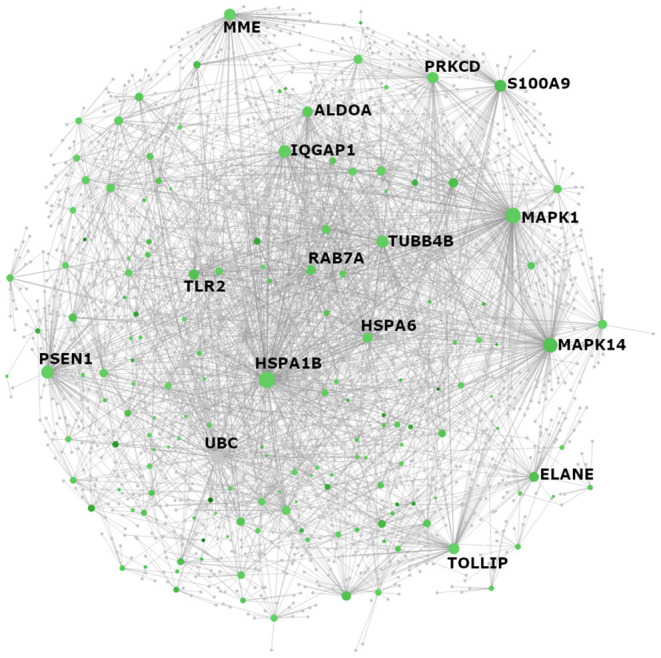
NetworkAnalyst visualization of Reactome pathway “neutrophil degranulation” genes with elevated expression in individuals from Endotype A. All genes with significantly higher expression in Endotype A that appeared in the Reactome PA category “neutrophil degranulation” (R-HSA-6798695) were visualized as a protein:protein interaction network using NetworkAnalyst. The color of each node reflects fold change between Endotypes A and B where green indicates higher expression in Endotype A. Gray nodes are genes that are not themselves differentially expressed (DE) but interact with other DE neutrophil degranulation genes. The size of each node (gene) reflects the number of documented interactions with other DE genes in the network. Thus, the largest circles have the greatest number of DE interacting partners and are predicted to be the most important regulators (“hub proteins”) of this network: inflammatory biomarker S100A8/A9, mitogen-activated protein kinases MAPK1 (ERK2) and MAPK14 (p38 MAPK), heat shock protein HSPA1B, the lysosome-associated glycoprotein LAMP2, tubulin TUBB4B, and Toll-like receptor protein TLR2 and its regulator/adaptor TOLLIP.